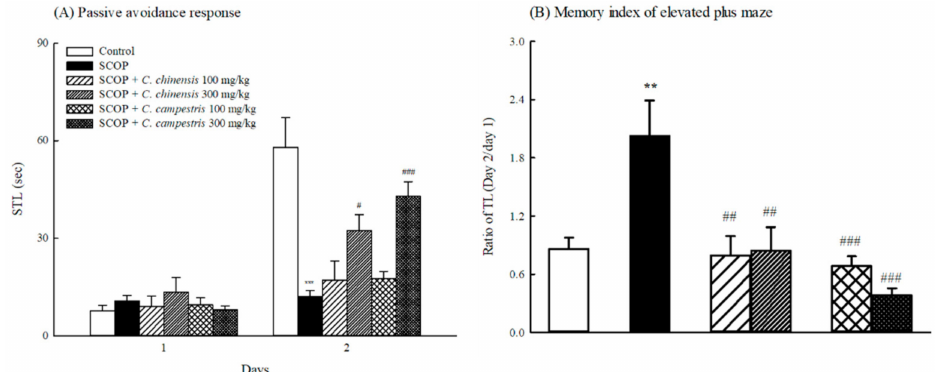
Figure 3. The effects of Cuscuta chinensis and C. campestris extracts (100 and 300 mg/kg, po) on ( A ) passive avoidance response and ( B ) memory index on elevated plus-maze in scopolamine (SCOP, 1 mg/kg, ip)-treated mice. Columns indicate mean ± SEM ( n = 7). ** p < 0.01, *** p < 0.001 compared with the control group. # p < 0.05, ## p < 0.01, ### p < 0.001 compared with the SCOP